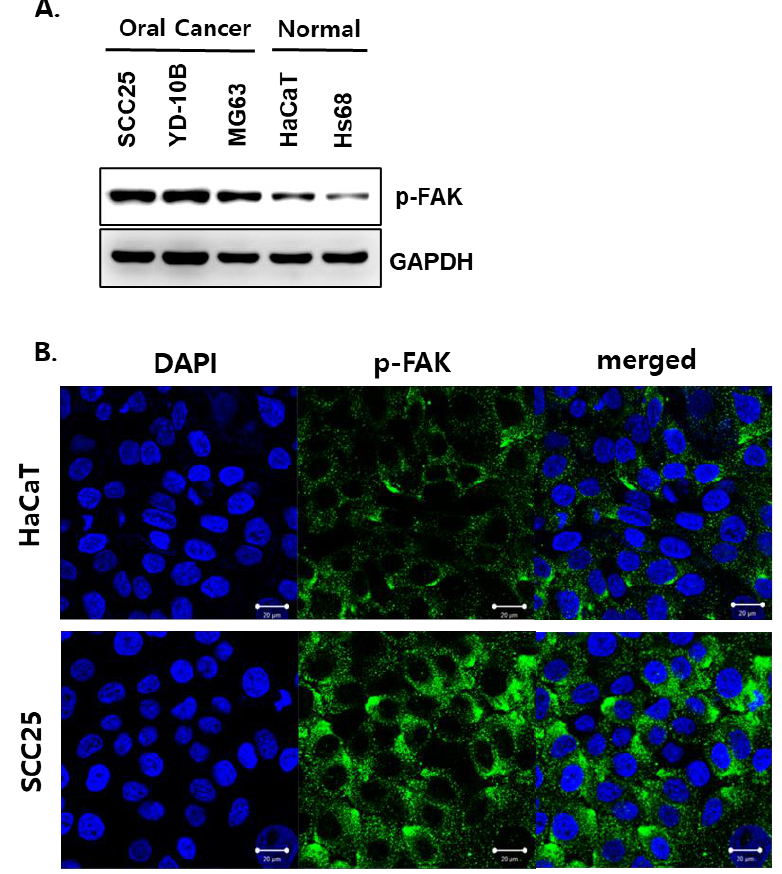
Figure 1. The p-FAK protein was overexpressed in oral cancers. ( A ) The basal expression level of p-FAK protein in oral cancer cells (SCC25, YD-10B and MG63) was compared with normal cells (HaCaT and Hs68) by performing Western blot assay. ( B ) The location and intensity of p-FAK protein in SCC25 and HaCaT cells was visualized through immunofluorescence assay. Scale bar: 20 μm.